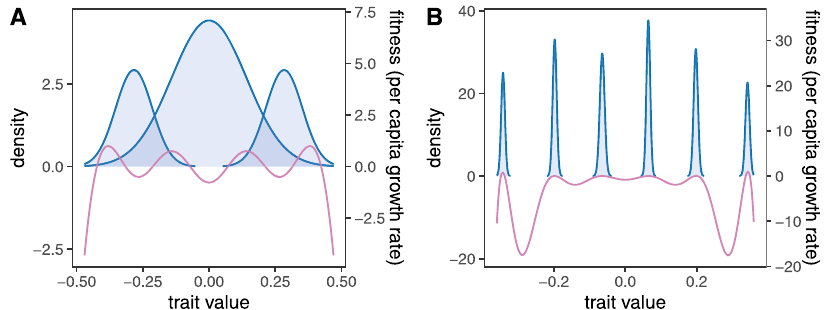
Fig. 2 Graphical overview of why species evolve narrower trait breadths in more tightly packed communities. Shaded curves are species' equilibrium trait distributions as in Fig. 1; the purple lines are the per capita growth rate of the corresponding phenotype, independent of species identity. This fi tness curve (right-hand ordinate) is obtained from Eq. (4) in the Methods. A With fewer species, there are regions with both positive and negative growth along the trait axis, which will act to increase and decrease trait density in those regions, respectively. Since the trait distributions are forced to be Gaussian by random mating, this will have the effect of increasing the trait variance to the point where this increase is counteracted by negative selection acting on extreme trait values. B In tightly packed communities, each phenotype experiences negative growth except at species' mean trait values where growth is zero. This means that selection eventually removes all genetic variance. Any remaining trait variation is environmental; i.e., stemming from developmental noise and other sources unaffected by